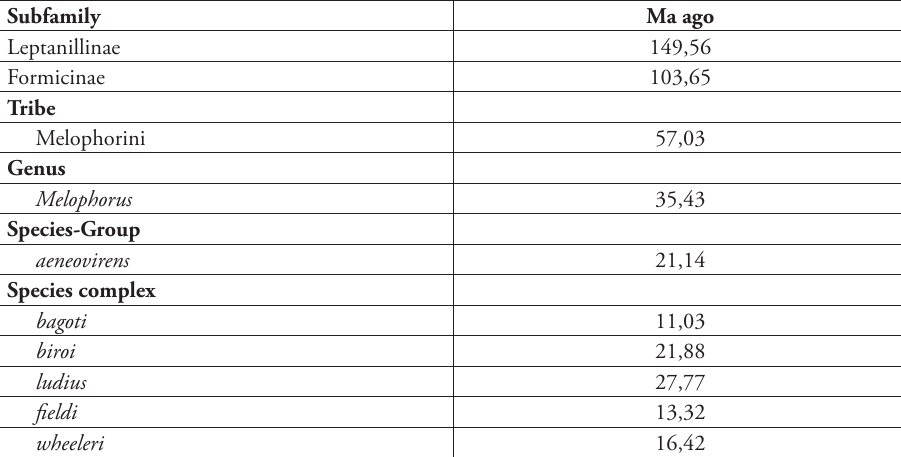
table 4. Summary of divergence dates (Ma ago) here proposed for select crown taxa including Melophorus species-groups and